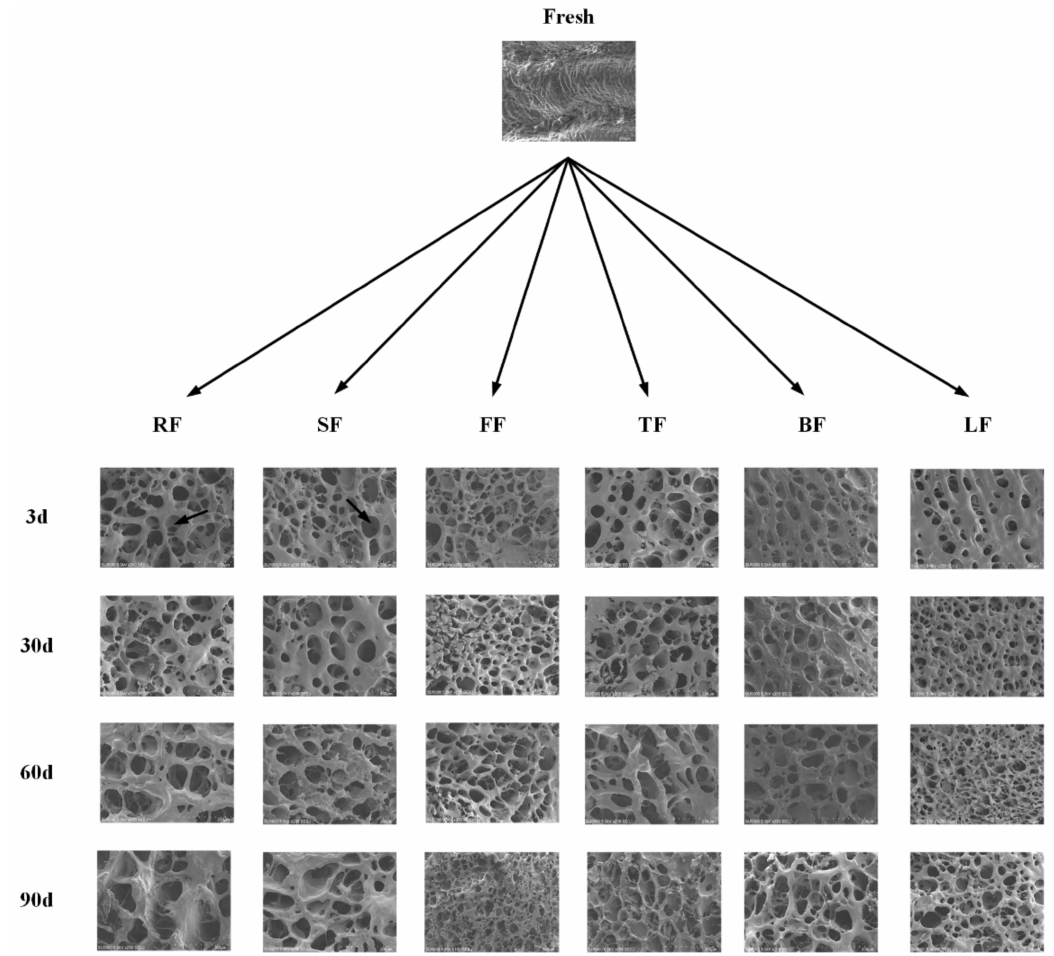
Figure 9. Scanning electron micrographs of cuttlefish during storage at − 18 ◦ C by different freezing